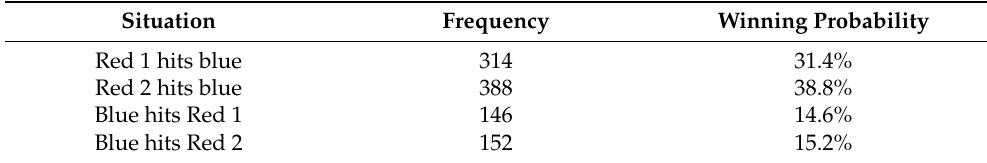
Table 3. Statistics of training